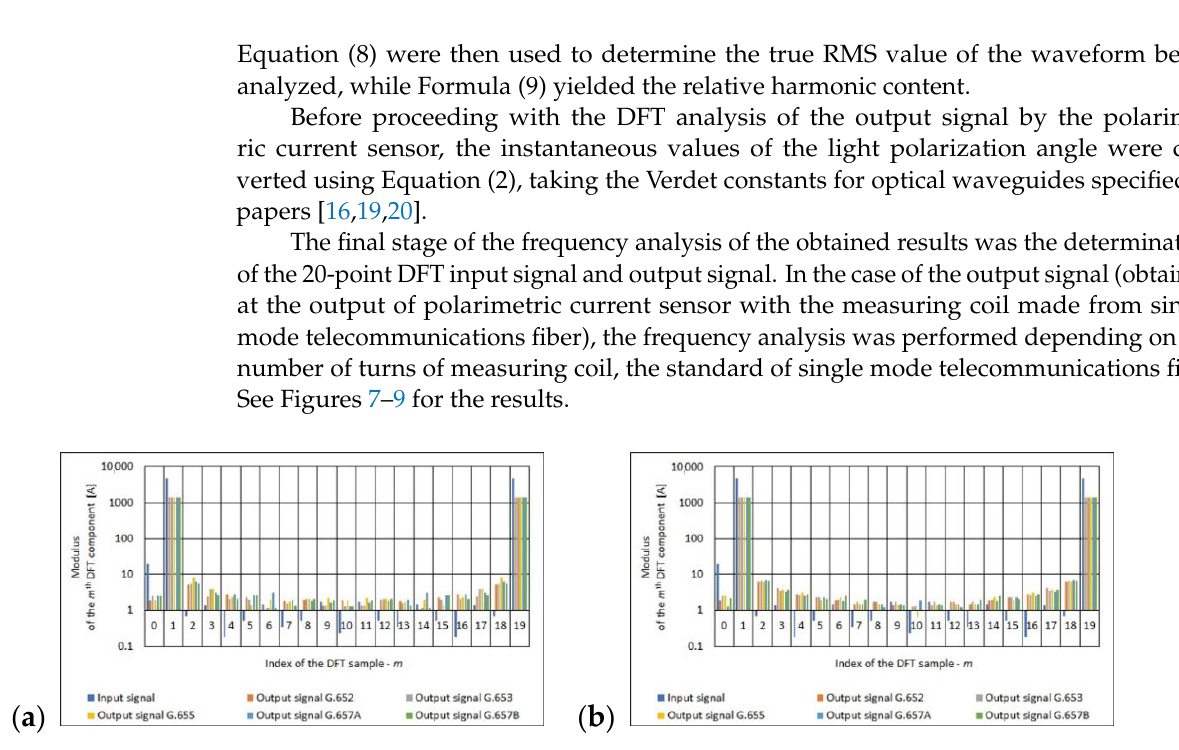
Sensors 2021 , 21 , x FOR PEER REVIEW Figure 7. Values of the m th DFT input component (100 A True RMS) and output component for the different standards of single mode telecommunications fibers [own results]: ( a ) for 40-turns measuring coil and ( b ) for 80-turns measuring coil.